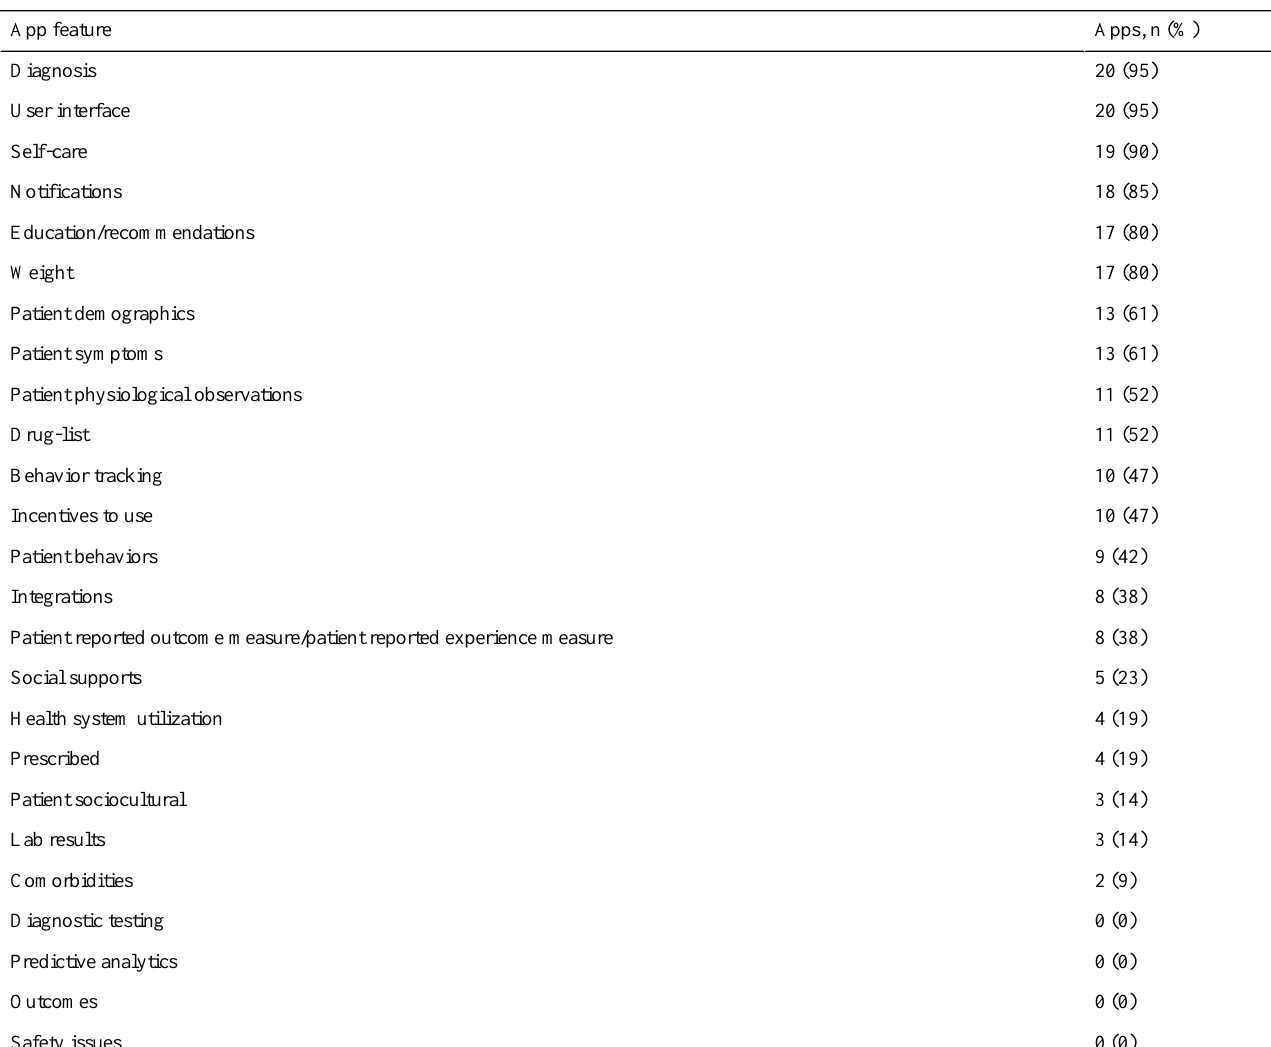
Table 3. Features present in filtered heart failure self-care apps